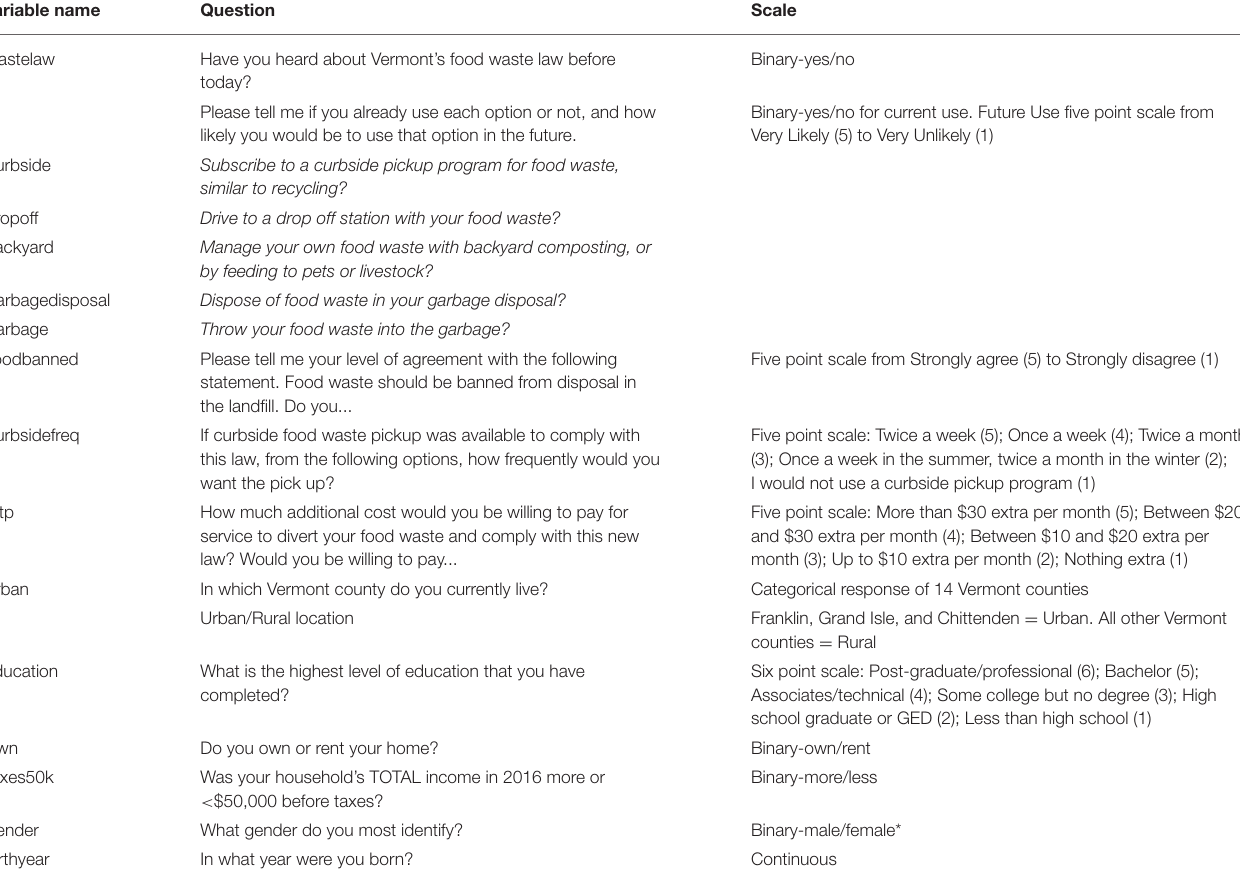
TABLE 1 | Variable names, questions and scales utilized for